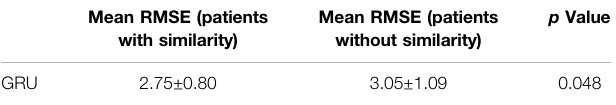
TABLE 2 | The mean RMSE between all pairwise patients. Mean value ± std (standard deviation). Mean RMSE (patients with similarity)